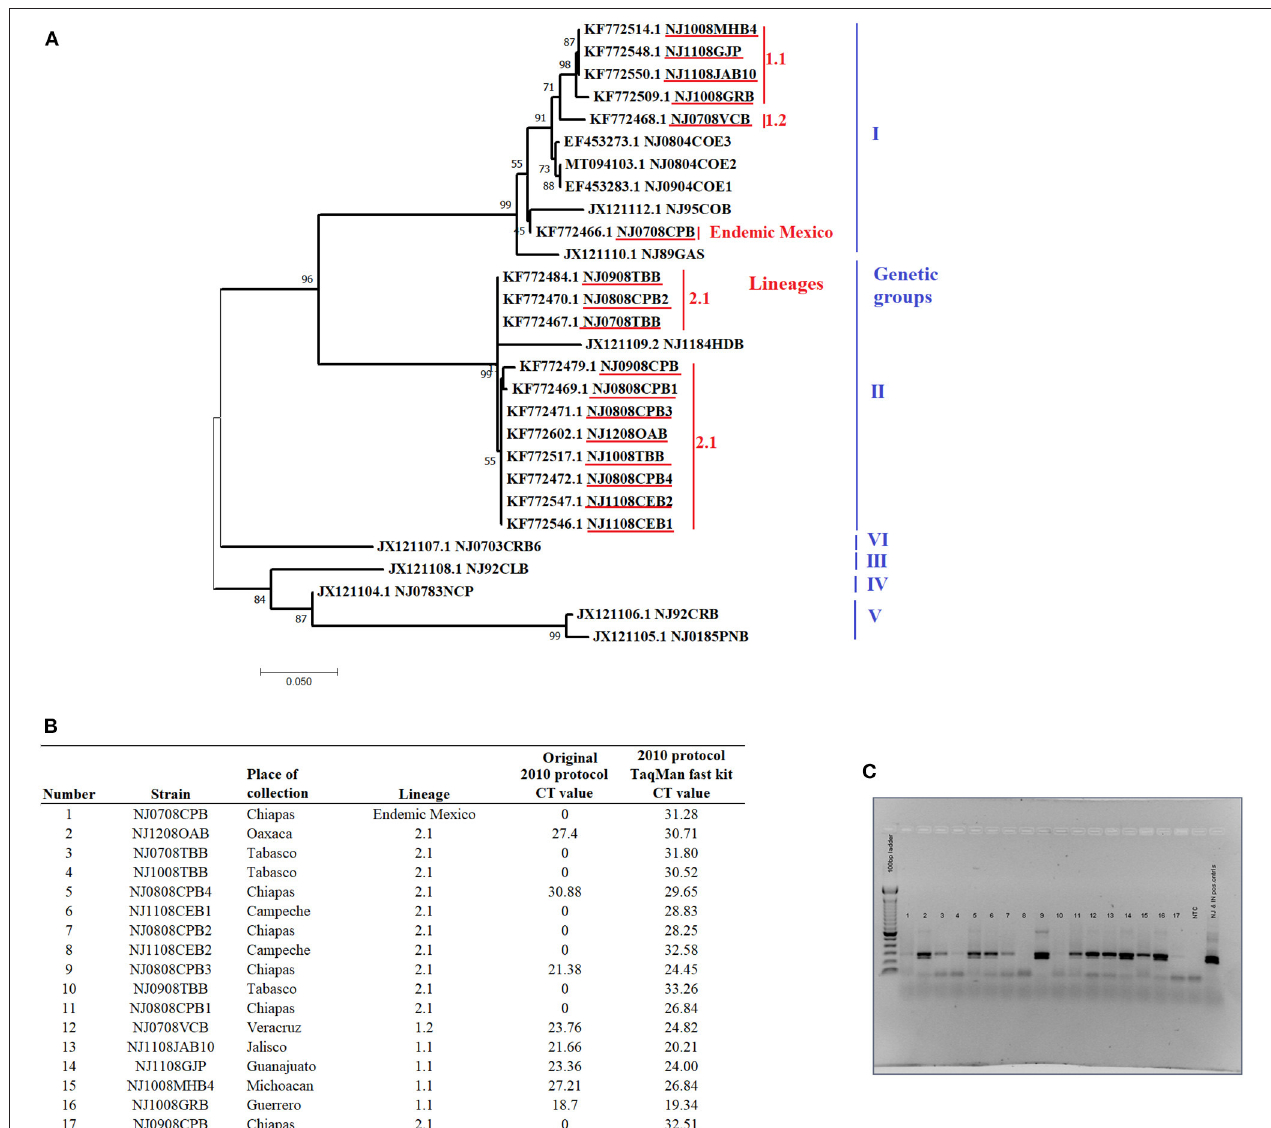
FIGURE 1 | General information and analysis of the 17 epithelial samples obtained from naturally infected livestock with VSNJV in Mexico during 2008. (A) Phylogenetic analysis reconstructed by maximum likelihood method representing the genetic relationship of VSNJV in the 17 tissue suspensions used for the validation of this study (highlighted in red). The analysis was enhanced using VSNJV isolates representing different genetic groups of this serotype. (B) Results of the comparison of the 2010 protocol using different master mix kits. (C) Gel visualization of the amplicons from the mRRT-PCR reactions using the original 2010 protocol.